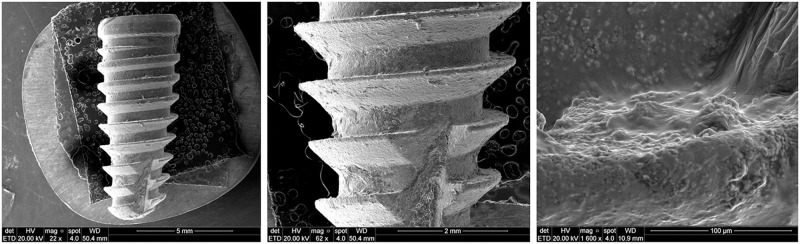
In (a) an image of low magnification of the implant showing the deposition of a thin layer of bone tissue over the entire surface. In (b) an image with more increase showing the bone tissue is deposited on the implant surface. In (c) an image with great increase showing the deposition of bone tissue on the surface, but with spaces between the lumps of bone tissue.